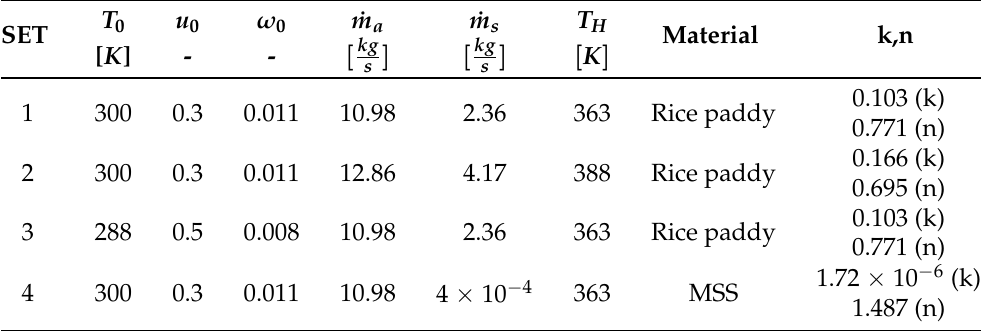
Table 1. The drying conditions of each set: T 0 and T H are the external and drying air temperature; ˙ m a and ˙ m s are the mass flow rates of the drying air and product; the terms u 0 and ω 0 measure the initial moisture content within the product and drying air and are expressed in kg of water on kg of dry